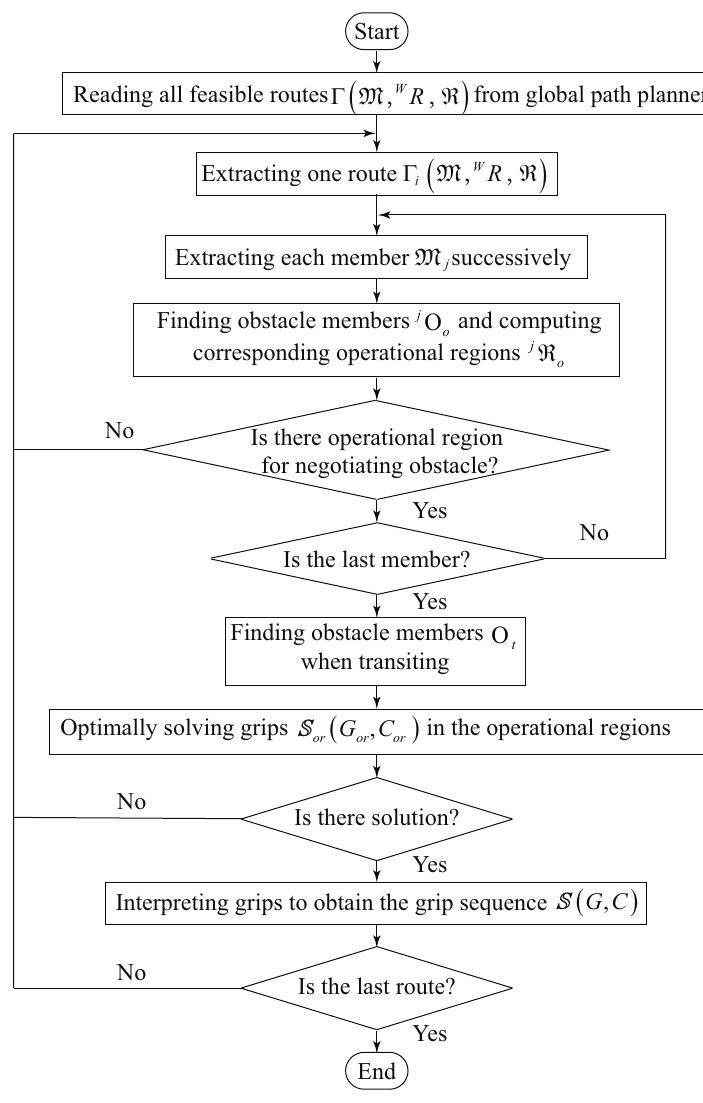
Figure 4. The flowchart of collision-free grip